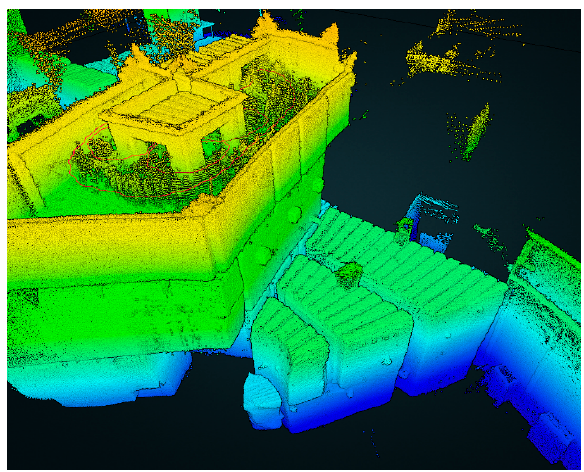
Figure 9. Graphical view on the captured point cloud coloured by hight.